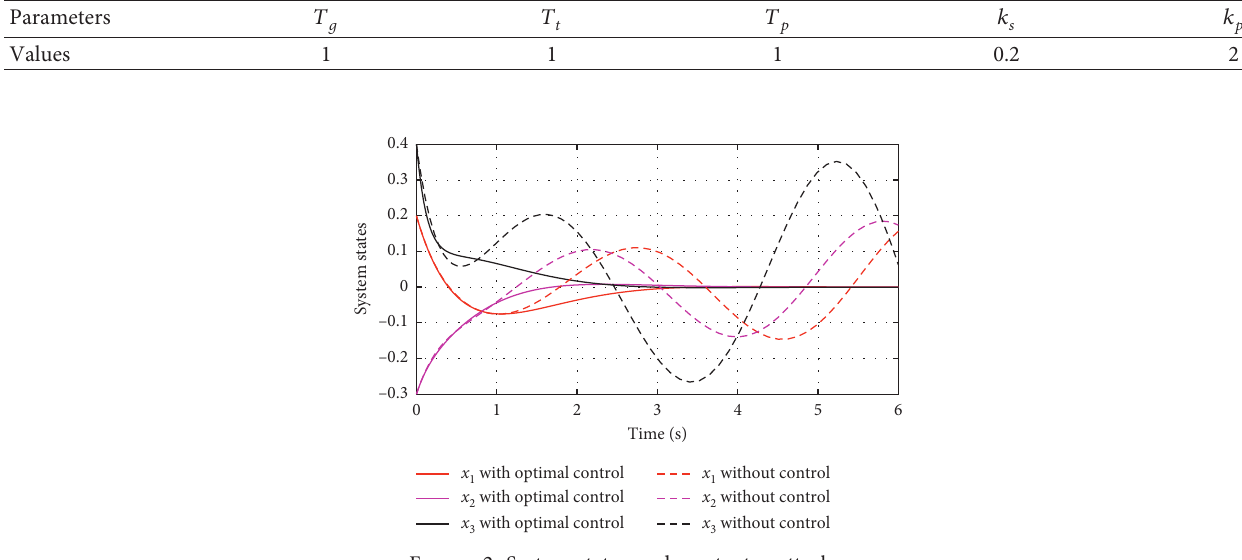
Figure 2: System states under actuator attacks.